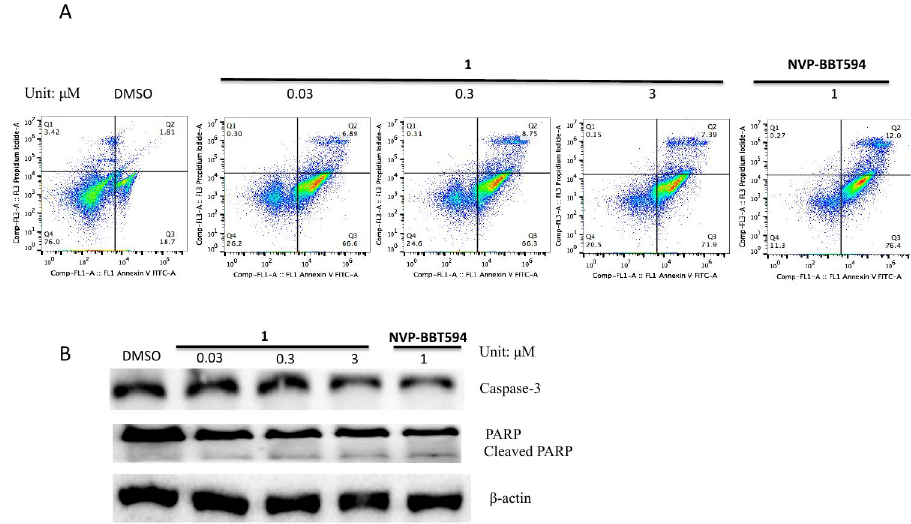
Fig 5. Compound 1 induces apoptosis in A375 cells. A375 cells were treated with the indicated concentrations of compound 1 (0.03 to 3 μ M) or positive control compound NVP-BBT594(1 μ M) for 24 h. (A) A375 cells were stainedwith PI and AnnexinV, and were analyzedby flow cytometry. (B) Protein lysates were analyzedby Western blotting with the indicatedantibodies.